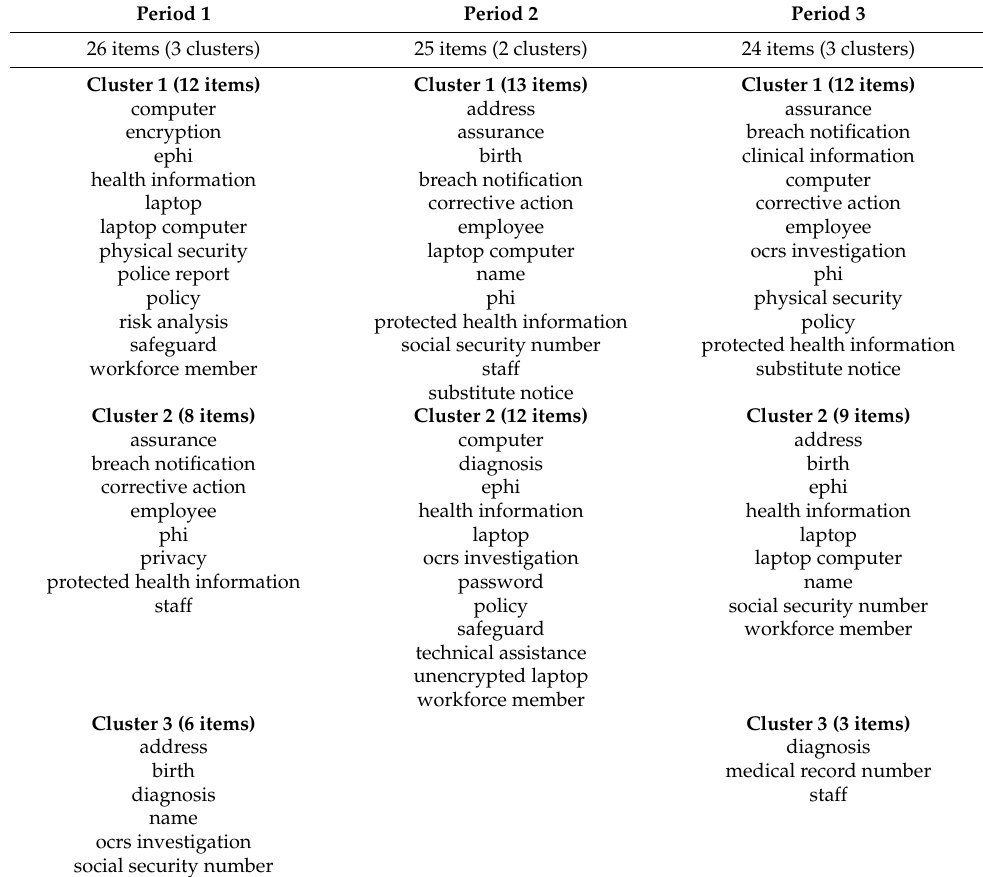
Table 3. Clusters of Co-occurring Keywords in Theft in Three